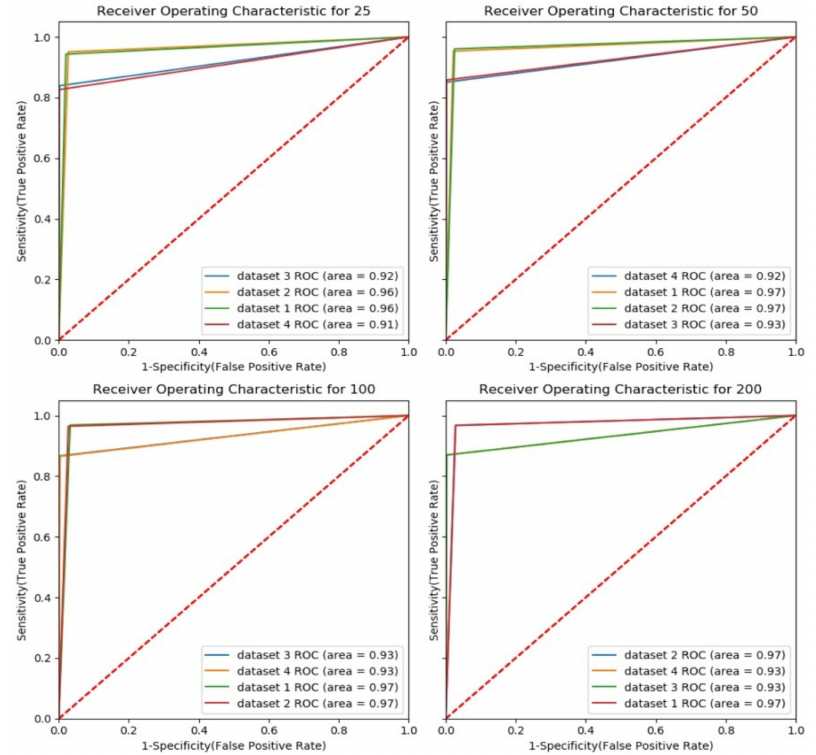
Figure 10. ROC curve for LSTM model results for each dataset as a third component in our en- sembl